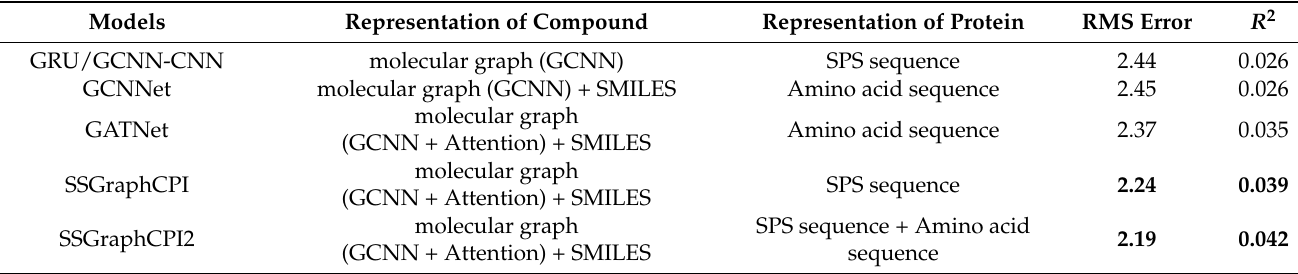
Table 4. RMS errors of different models on the GPCR